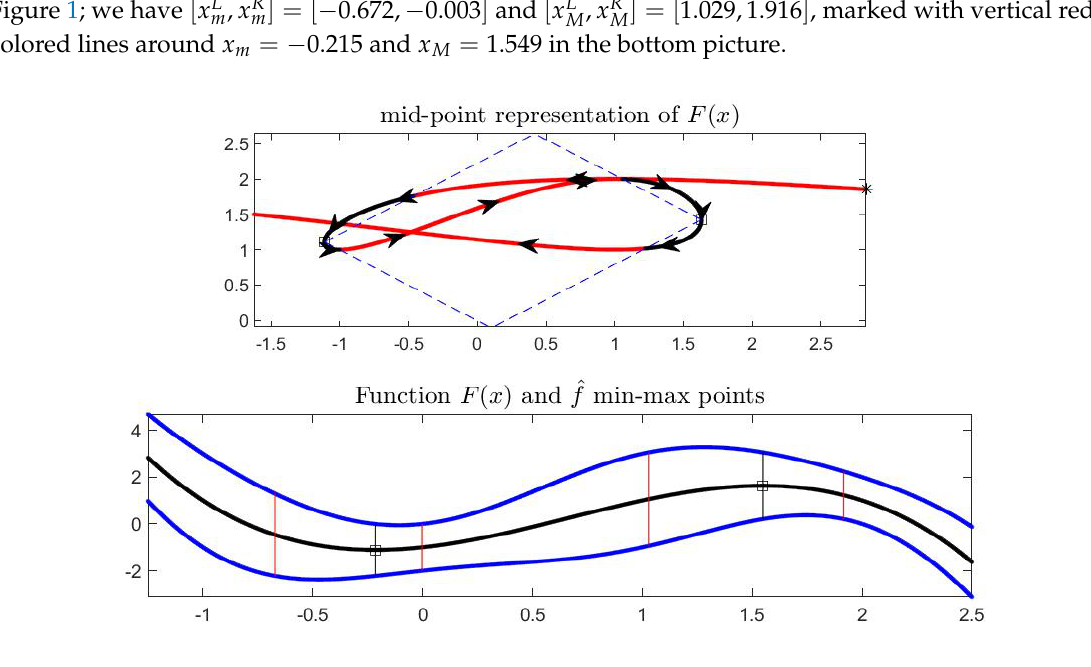
Figure 1. Local min and max points of F ( x ) in Example 1; function (cid:98) f ( x ) has a minimum point at x m = − 0.215 and a maximum at x M = 1.549. Black colored intervals in midpoint representation ( top picture ) are not dominated by F ( x m ) = ( − 1.113;1.110 ) for the local min and are not dominated by F ( x M ) = ( 1.631;1.424 ) for the local max. They correspond to the domain subintervals [ − 0.672, − 0.003 ] and [ 1.029,1.916 ] delimited by vertical red lines in the bottom picture